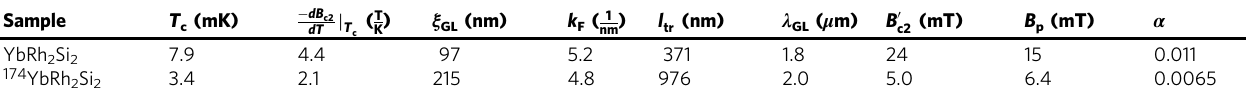
Both T c ( B ) and B c2 ( T ) are de fi ned as the midpoints of the resistive transitions (see Figs 1c, d and 2a, b). The zero- fi eld values T c [ = T c ( H = 0)] as well as the upper critical fi eld slopes (cid:1) dB c2 = dT j T determinedfromlinear fi tstothedataatsmall fi elds(redlinesinFig.4).ListedarealsoestimatesoftheGinzburg – Landaucoherencelength ξ GL ,theaverageFermiwavevector k F ,thetransportscattering length l tr ,theGinzburg – Landaupenetrationdepth λ GL ,the(orbitallimiting)uppercritical fi eld B 0 c2 ,andthePaulilimiting fi eld B p (seetext). α istheprefactorofthescatteringrate1/ τ = α k B T / ℏ ofasimple Drude conductor, estimated from T c , ξ GL (both below), and γ 0T KW (from Table 1), as explained in the Supplementary Note 2: Estimates on Planckian dissipation; “ Planckian dissipation ” refers to α =